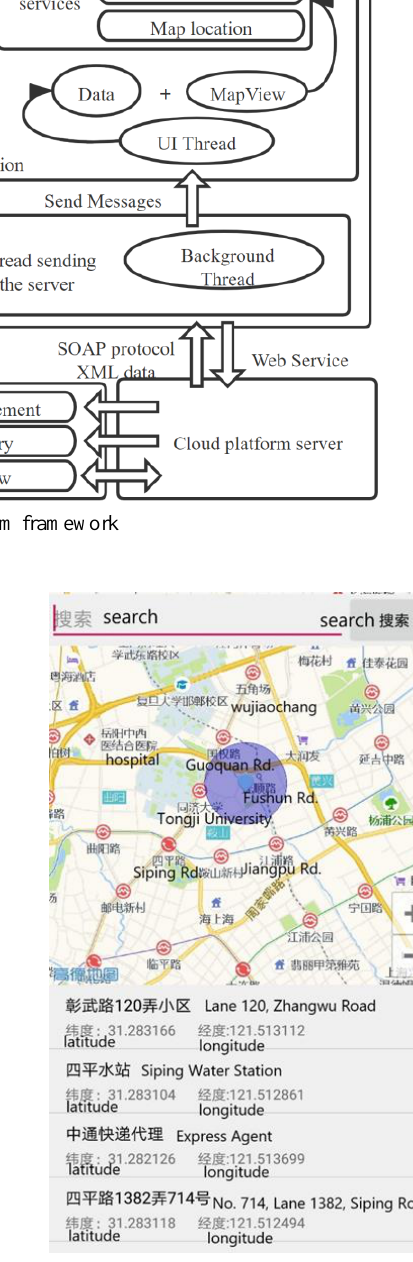
Figure 3. Illegal solid waste reporting interface Figure 4. Gaode mobile map location